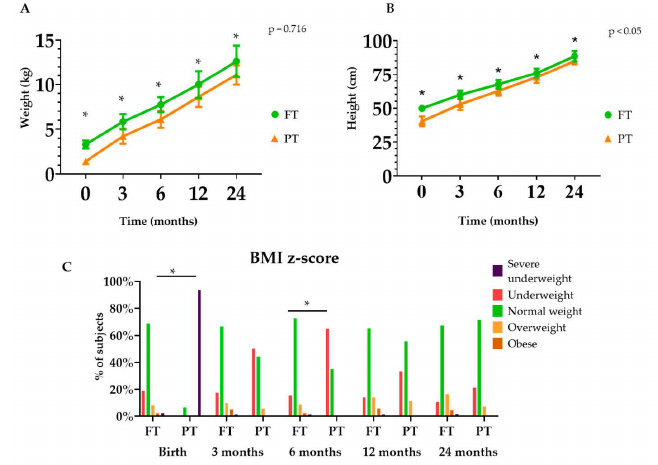
Figure 2. Weight ( A ), height ( B ) and ( C ) BMI z-score during the first 2 years of life between full-term (FT) and preterm (PT) infants. Chi-square was used for intra-group comparisons. * p < 0.05. The p -values presented in the graph correspond to a two-way ANOVA controlled by time.